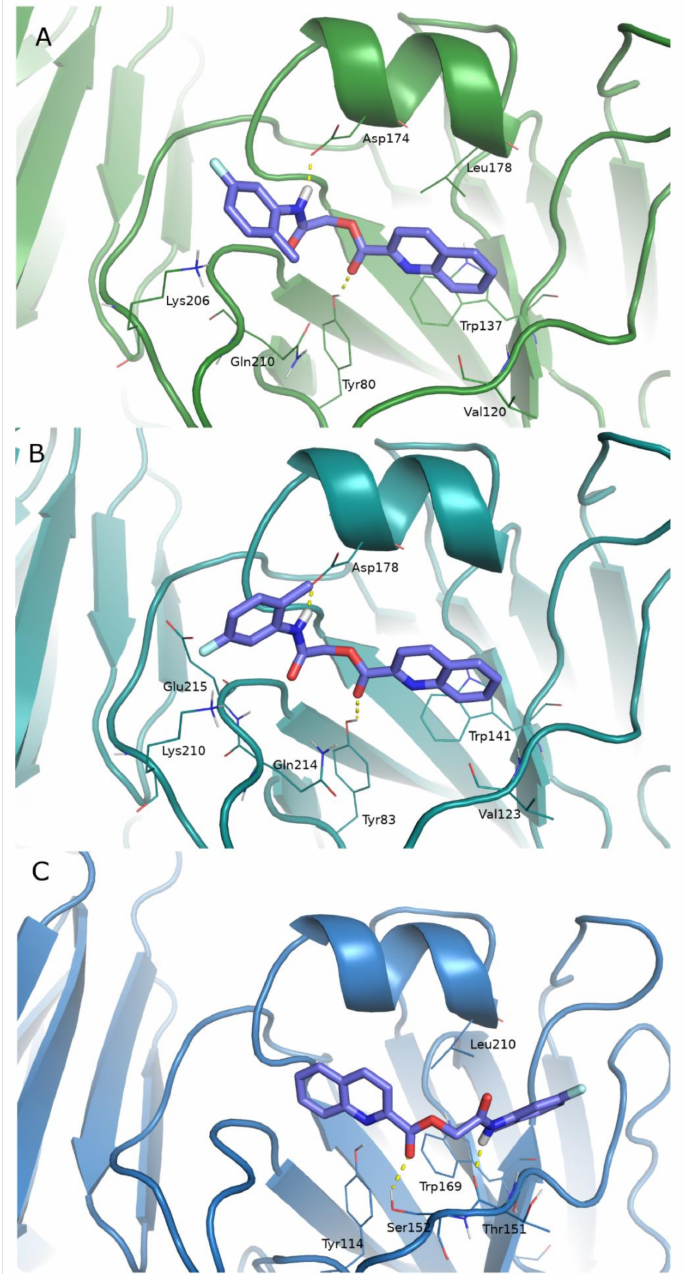
Figure 4. Docked pose of ligand 4 (stick, violet C atoms) in the RBS of the HA of A/Parma/H1N1, green cartoon ( A ), A/Roma/H1N1, cyan cartoon ( B ), and A/Parma/H3N2, pale blue cartoon ( C ). HA residues involved in the ligand binding are represented as